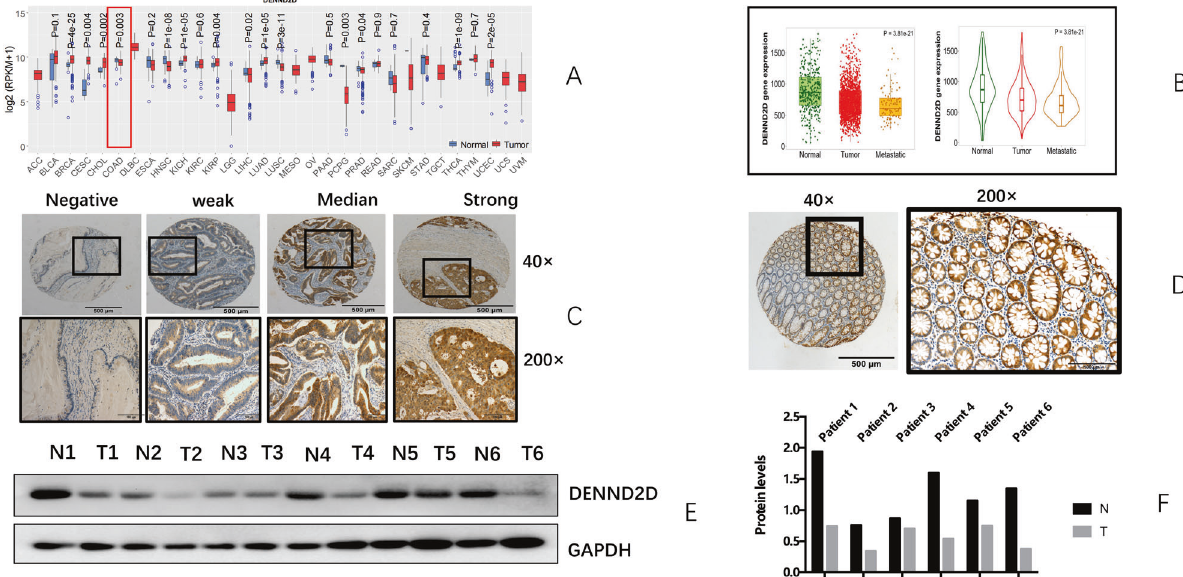
Fig. 1 DENND2D is more highly expressed in adjacent normal tissues than colorectal cancer tissues, con fi rmed by online database and our clinical samples. A Expression level of DENND2D across 31 TCGA cancer types, in comparison with their normal controls if available. The middle line in the box is the median, the bottom and top of the box are the fi rst and third quartiles, the whiskers extend to 1.5 IQR of the lower quartile and the upper quartile respectively, and the black solid circles represent outliers. P values were derived from two-sided Wilcoxon ’ s rank-sum test. B DENND2D gene expression among normal, tumor, and metastatic tissues in colorectal cancer patients obtained from the TNMplot.com web tool. C Protein expression of DENND2D in colon cancer tissues from 181 stage IV CRC patients. The level of DENND2D was classi fi ed as negative, weak, moderate, and strong. Protein expression of DENND2D in normal tissue (×40 and ×200). D Protein expression of DENND2D in normal tissues. E , F Western blot analysis of six pairs of tumor tissues and normal tissues from six colon cancer